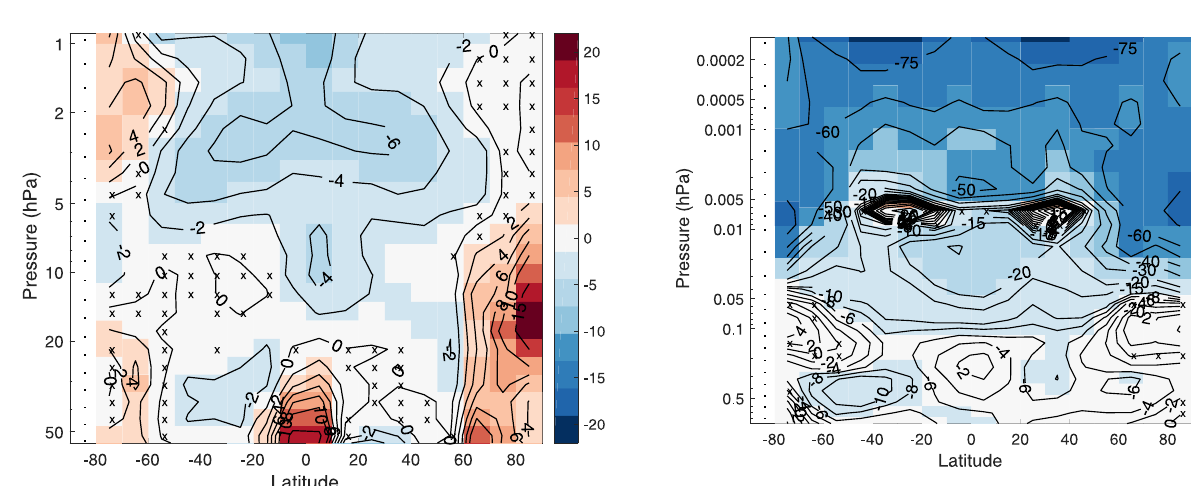
Figure 2. The median relative difference (WACCM– GOMOS)/median(GOMOS) of the ozone mixing ratio (in %) in the stratosphere over 2002–2011. Latitudes are from − 90 to + 90 ◦ with 10 ◦ resolution. A crossed cell marks a point where the difference does not deviate from zero in a statistically significant way. A cell with a dot marks a point where there are no collocated profiles.